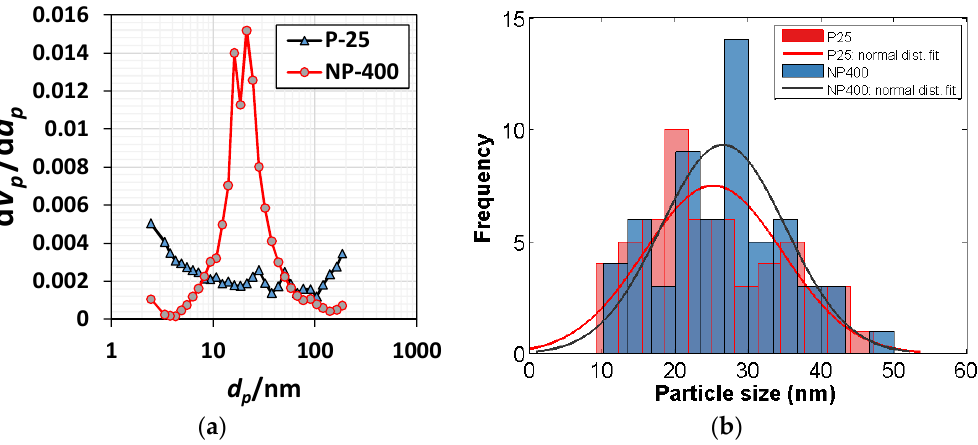
Figure 2. Pore distribution and particle size: ( a ) Barrett–Joyner–Halenda (BJH) plots to characterize the frequency distribution of pores; and ( b ) particle size distribution (nm) from TEM images.